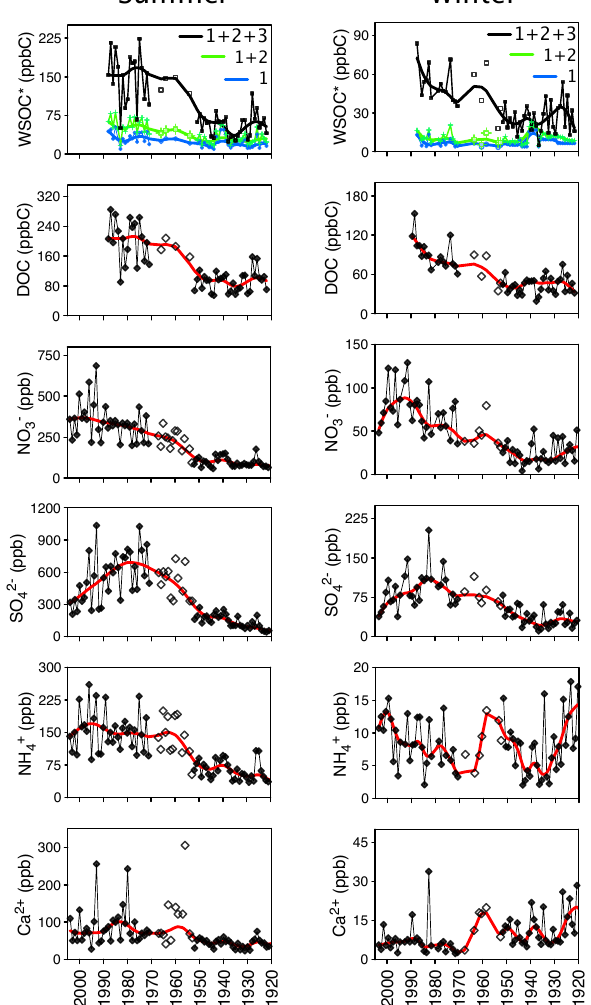
Fig. 7. Long-term trends extracted from summer (left) and win- ter (right) CDK snow and ice layers. From top to bottom: proxy of water-soluble organic carbon (WSOC ∗ , see Sect. 4.2), dissolved organic carbon (DOC), nitrate, sulfate, ammonium, and calcium. On the WSOC ∗ panel, the numbers 1, 2, and 3 refer to HULIS (blue line), the sum of HULIS and dicarboxylates (green line), and the sum of HULIS, dicarboxylates and an unknown fraction (black line) (see Sect. 4.2). For calcium, the Saharan dust events have been removed from the data. The solid symbols correspond to the well-dated part of the CDK ice core, the open symbols to samples from the C11 ice core (see Sect. 2.1). The thick solid lines are ro- bust spline smoothings. Except for NH + and Ca 2 + , the panels are 4 adapted from Legrand et al.